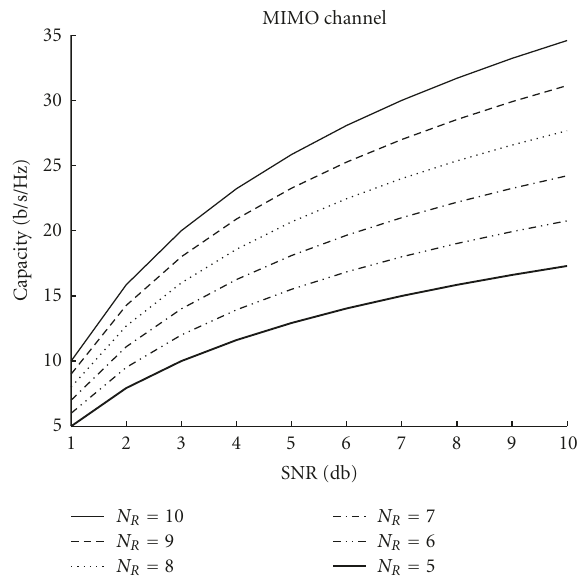
Figure A.1: Average capacity for MIMO systems. Curve in bottom is for N R = 5 and top one for N R = 10.